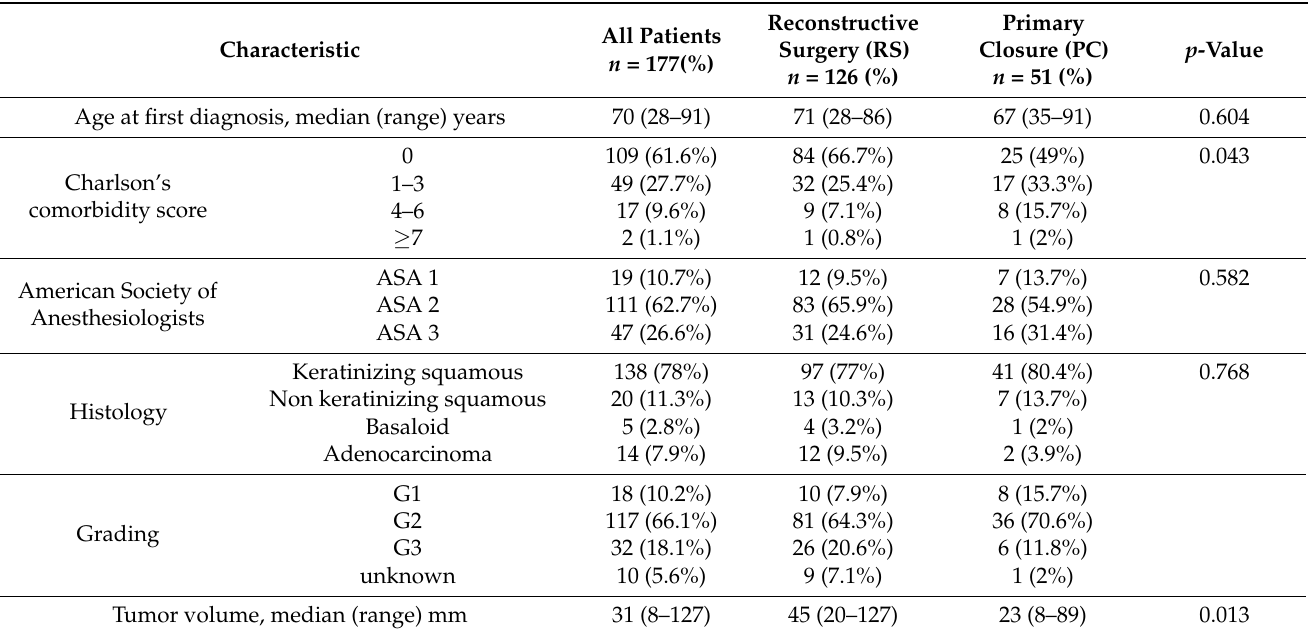
Table 1. Patient’s and tumor’s